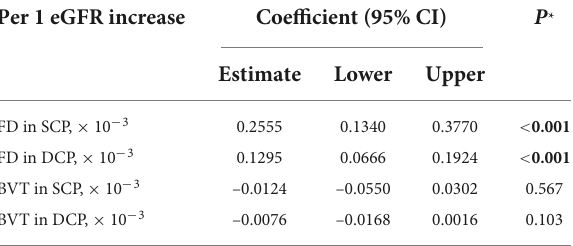
TABLE 4 Multivariable linear regression of renal function with measurements of fractal dimension and blood vessel